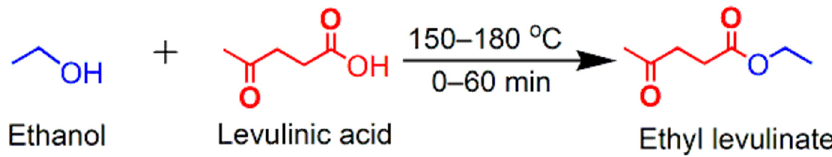
Figure 9. IR spectra of pyridine adsorption after desorption at ( a ) 150 °C and ( b ) 300